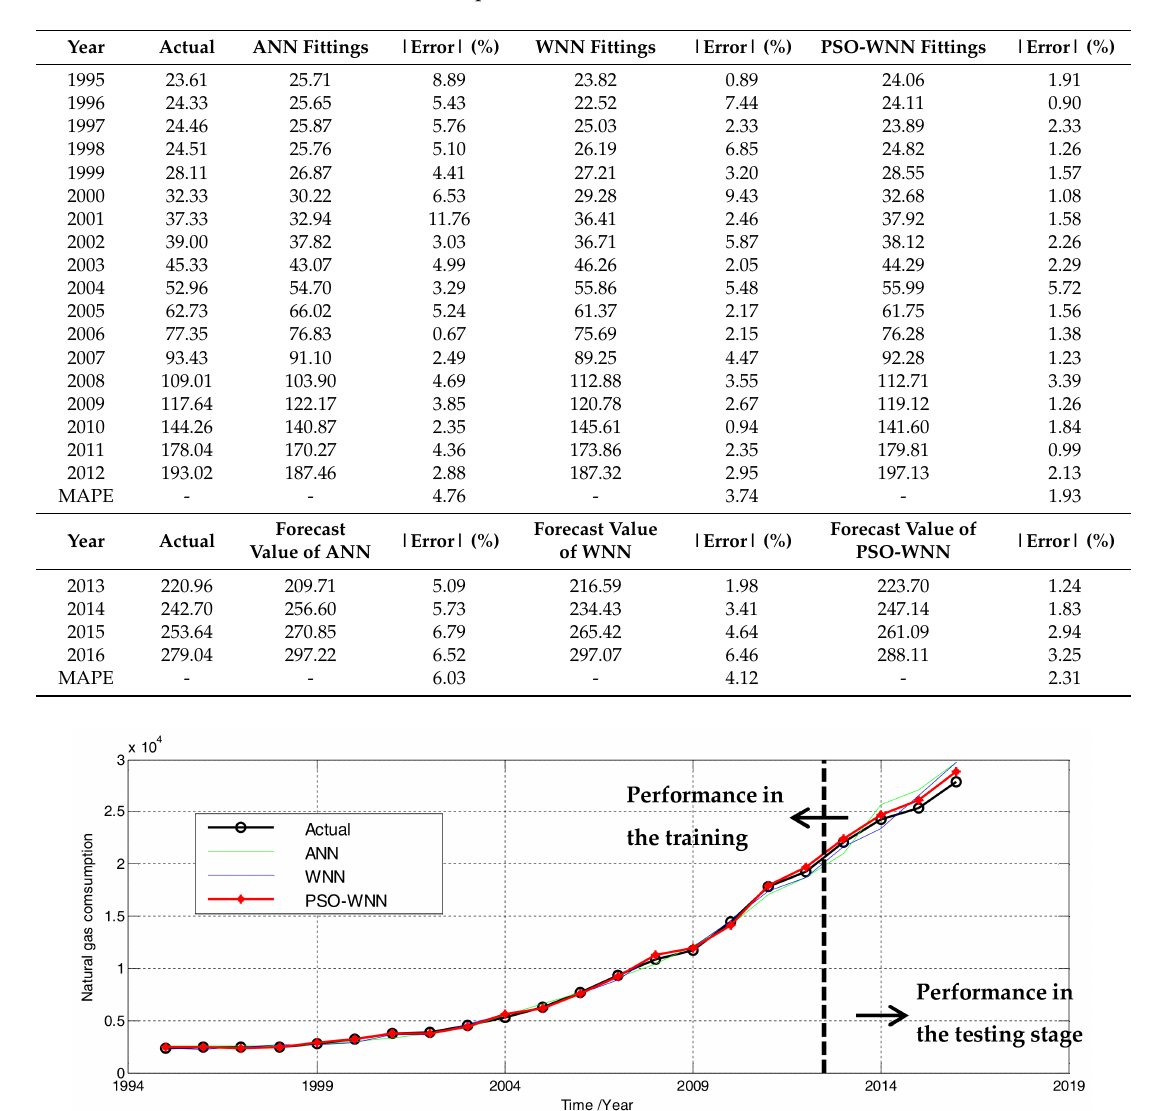
Table 4. Performance comparison of ANN, WNN and PSO-WNN models.